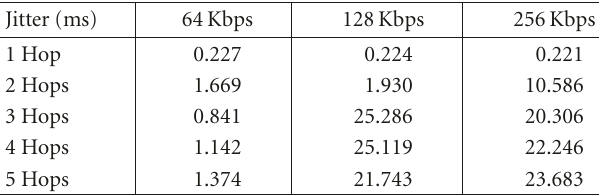
Table 6: Jitter: unicast routing and